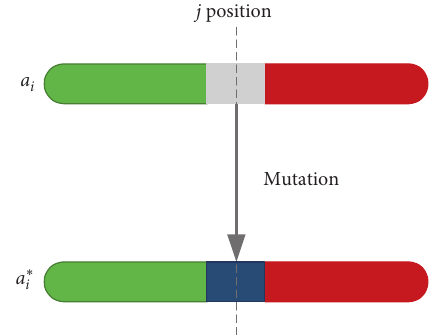
Figure 5: An example of mutation operation. The chromosome information at j position of a